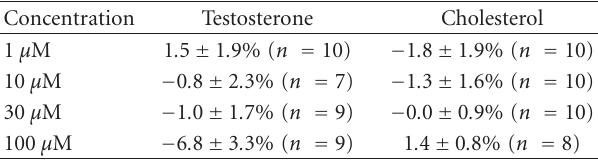
Table 2: Inhibitory e ff ect of testosterone and cholesterol